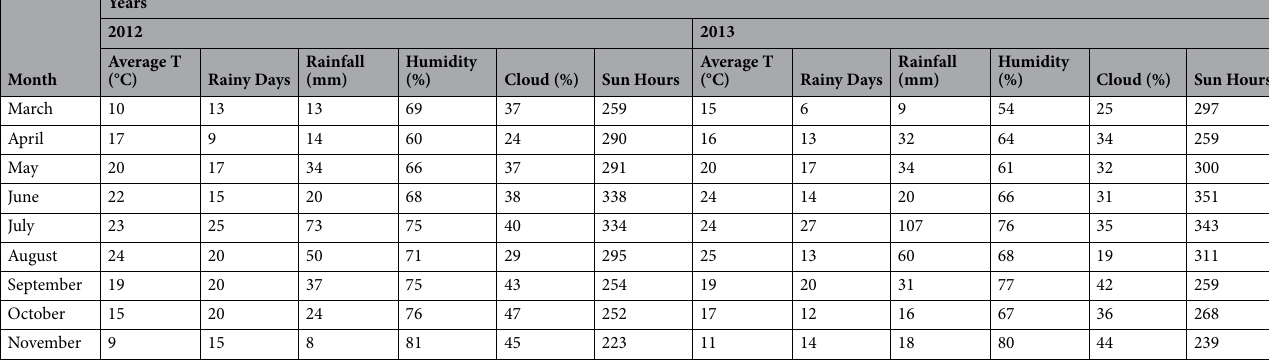
Table 8. Average temperature (T), rainy days, rainfall, humidity, cloud, and sun hours from March to November in cropping seasons of 2012 and